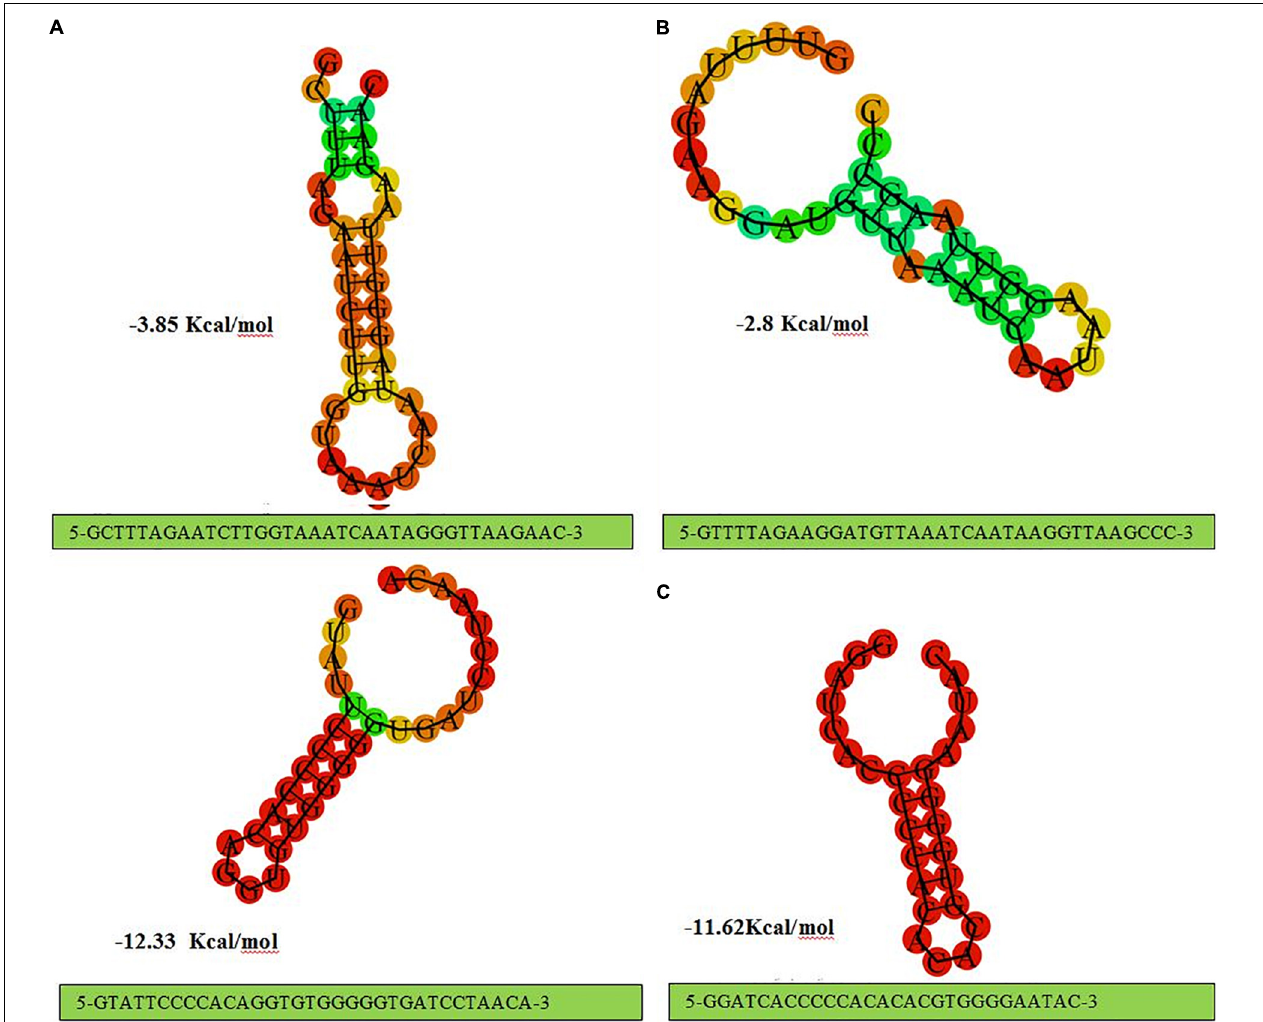
FIGURE 2 | The prediction of consensus direct repeat secondary structure and corresponding MFE values in type II-A (A) ; type II-C (B) ; and type I-E (C) .